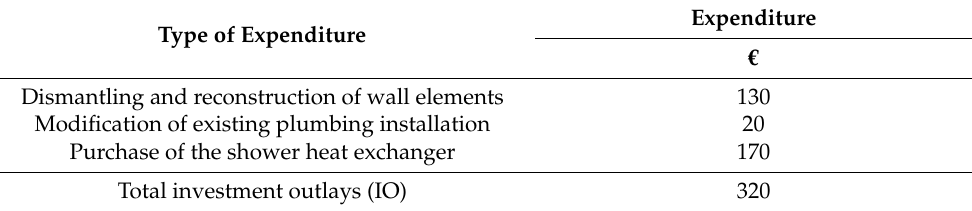
Table 3. Investment outlays needed to implement the compact shower heat exchanger under Polish conditions.